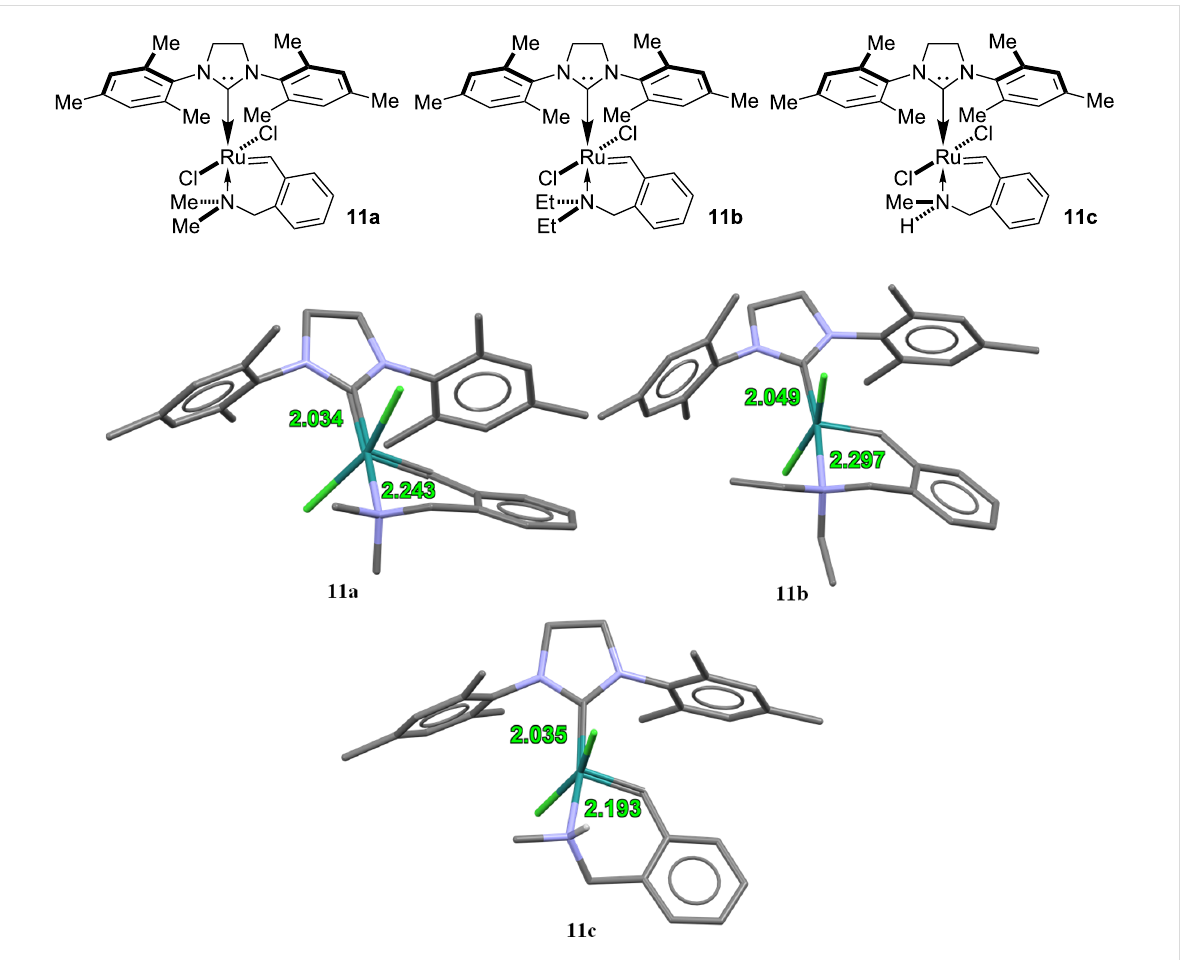
Figure 3: Selected X-ray data for ruthenium complexes 11a – c . All hydrogen atoms were deleted for clarity (except for the hydrogen atom belonging to the NH group in compound 11c ).